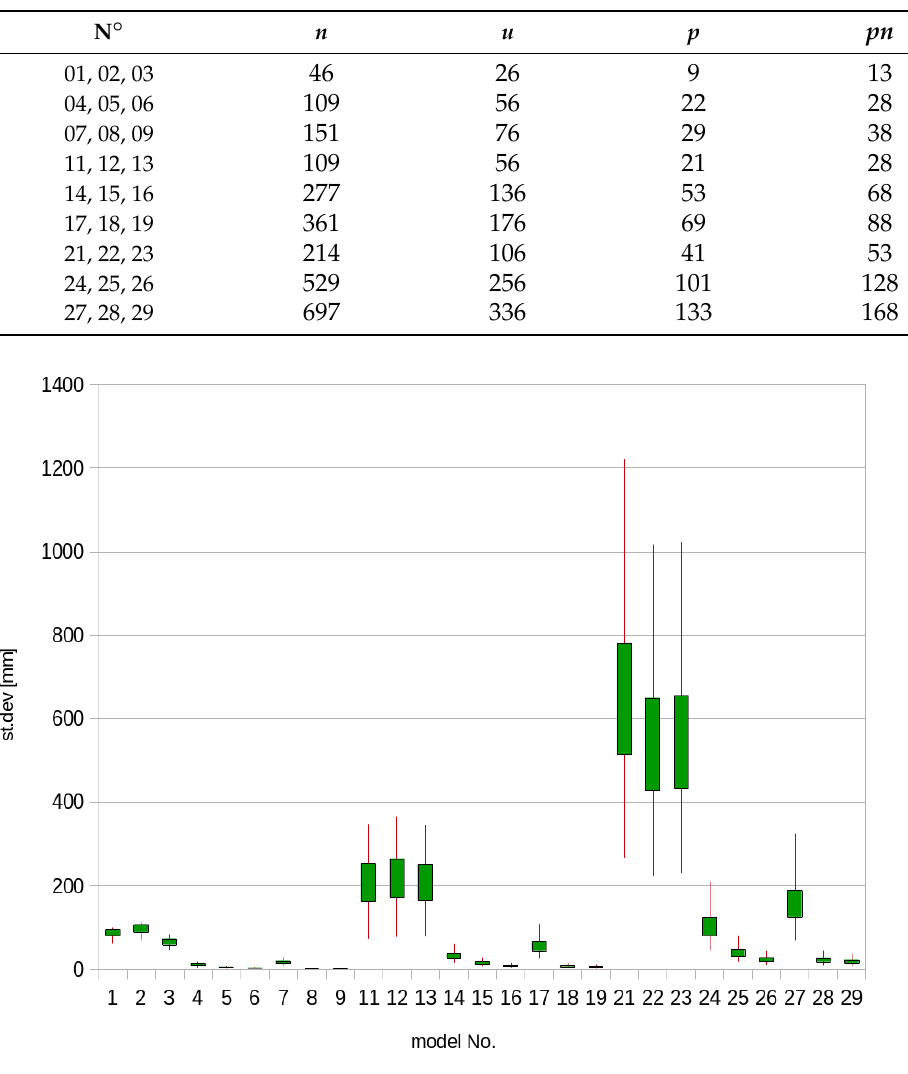
Figure 7. Adjustment quality